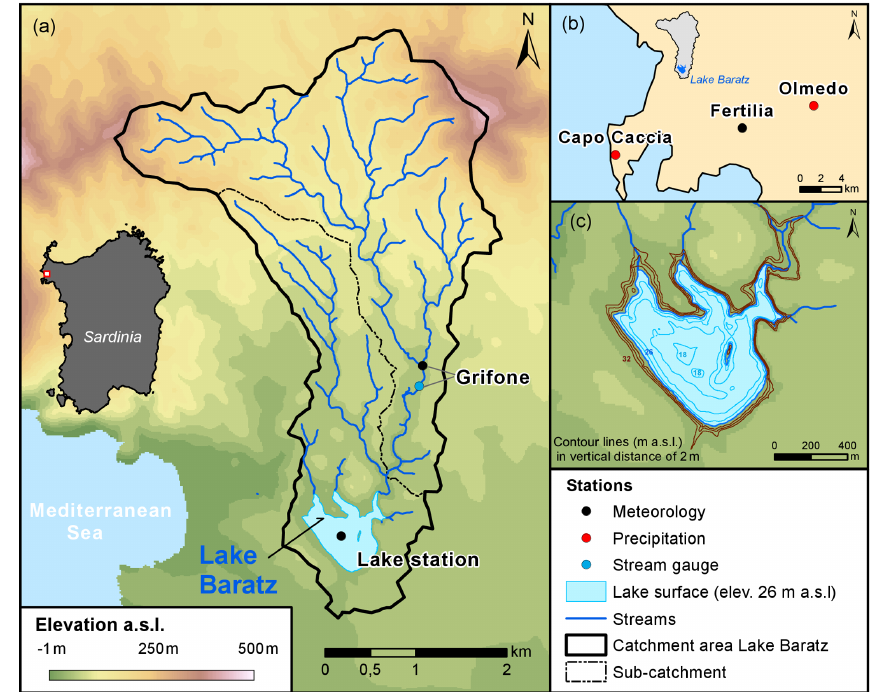
Figure 3. (a) Lake Baratz and its hydrological catchment area and observation station; (b) observation stations outside of the lake watershed (gray area); (c) contour lines of the lake basin. The blue area indicates the lake surface at a lake level of 8m (equal to an elevation of 26ma.s.l.) observed in November 2012. Brown lines display dry terrain and cyan isobaths at this lake level (Source DEM © Regione Autonoma della Sardegna).